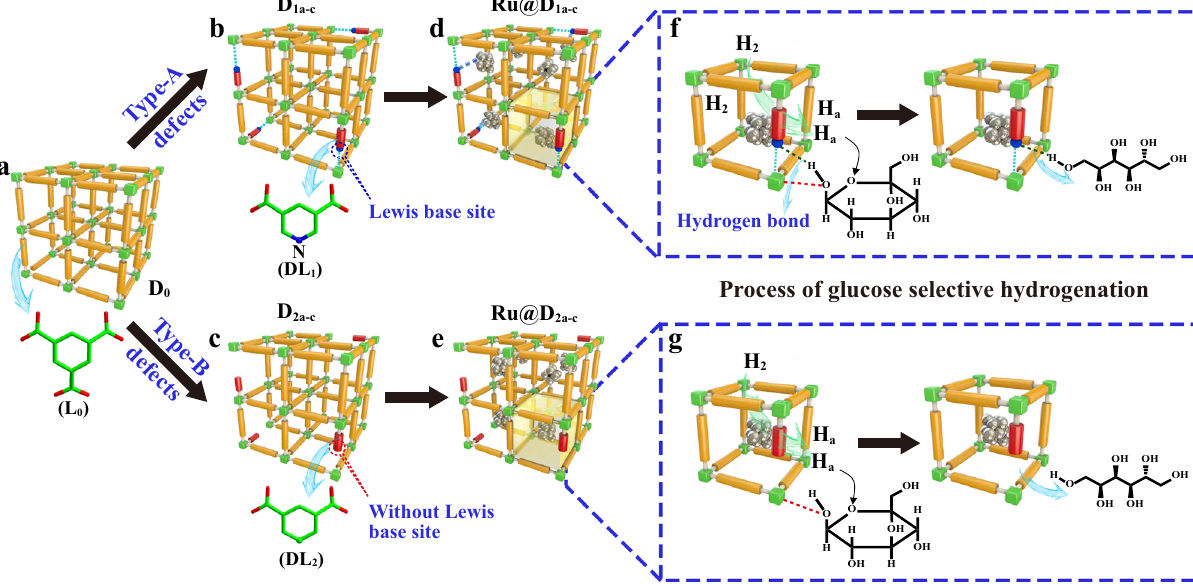
Fig. 1 Formation of two different types of defects and their corresponding catalytic mechanisms. a – e Schematic illustration of parent MIL-100-Cr MOF D 0 ( a ), D 1a-c DEMOFs with type-A defects, generated via incorporation of DL1 with a weak ligator (pyridyl-N) at defect sites ( b ), D 2a-c DEMOFs with type-B defects, generated via incorporation of DL2 without ligator at defect sites ( c ), Ru-impregnated D1a-c catalysts (Ru@D 1a-c ) ( d ), and Ru-impregnated D 2a-c catalysts (Ru@D 2a-c ) ( e ). f , g Proposed D-glucose hydrogenation mechanisms catalyzed by Ru@D 1a-c ( f ) and Ru@D 2a-c catalysts ( g ). The yellow sticks, the shorter red sticks with a blue ball, and the bare shorter red sticks represent parent L0, DL1, and DL2 ligands, respectively. The green cubes represent metal sites. Both f and g show the enlarged perspective views of the unit containing defect